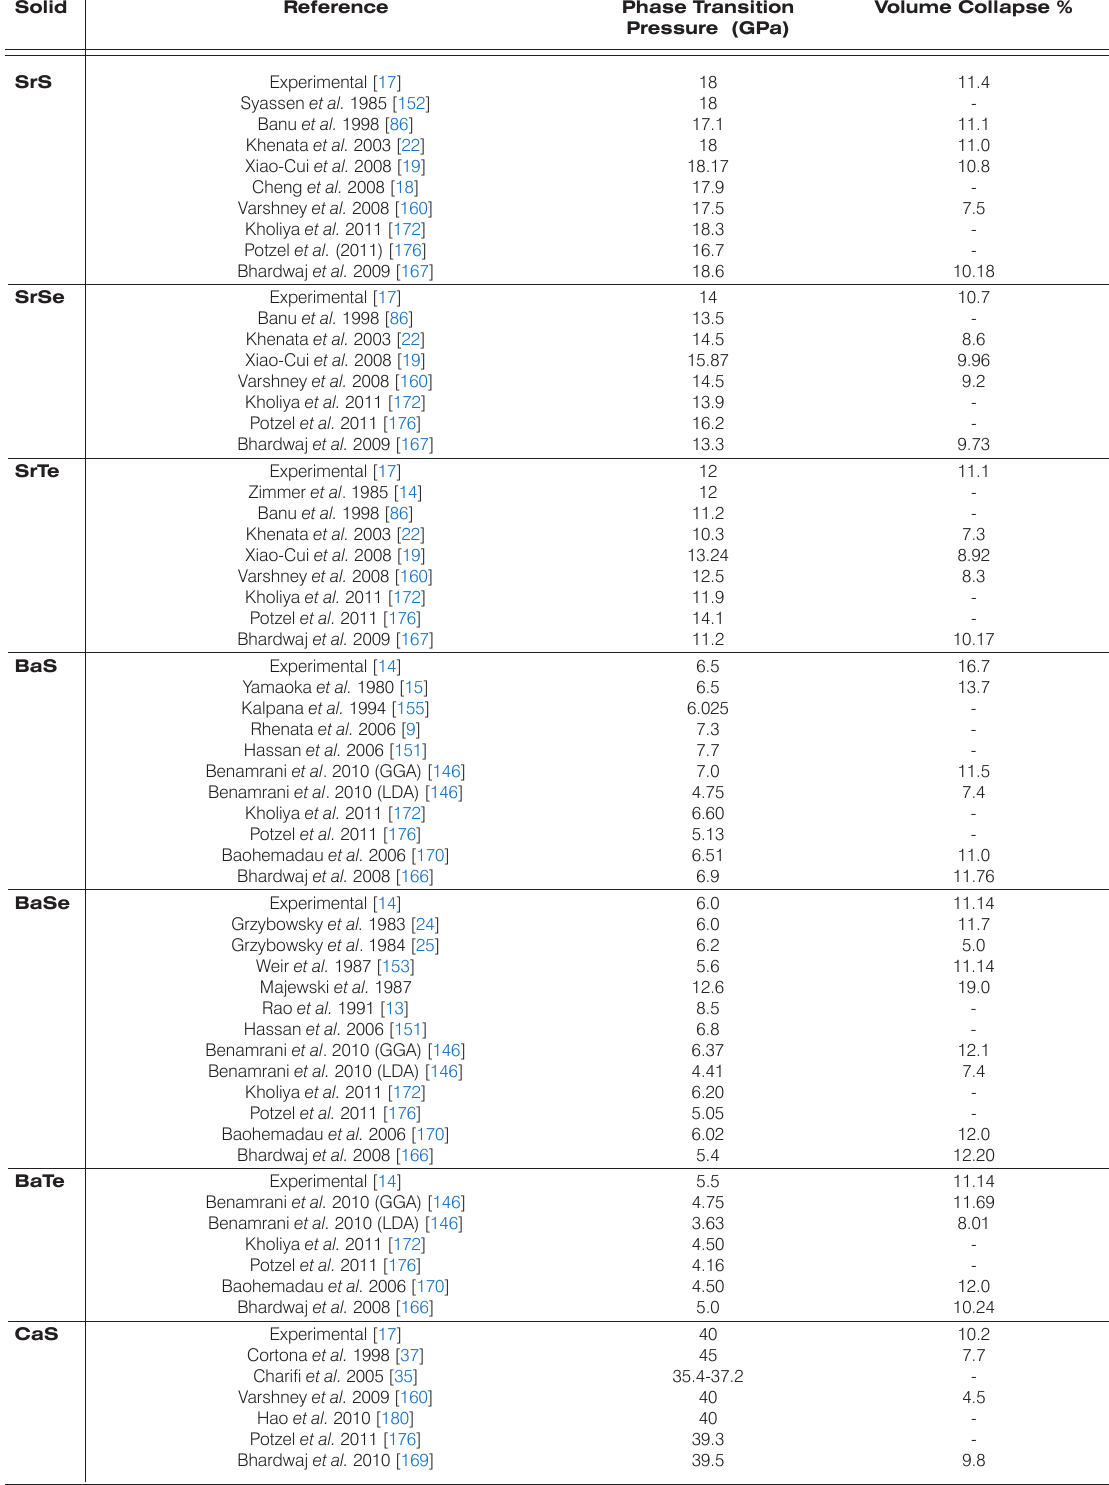
Table 2. Phase transition pressure and volume